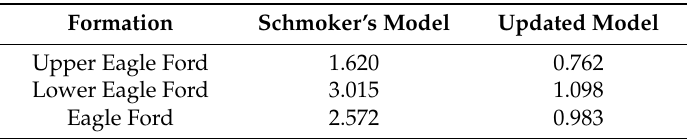
Table 2. Root mean square error (RMSE) analysis of TOC estimations based on Schmoker’s model and the updated